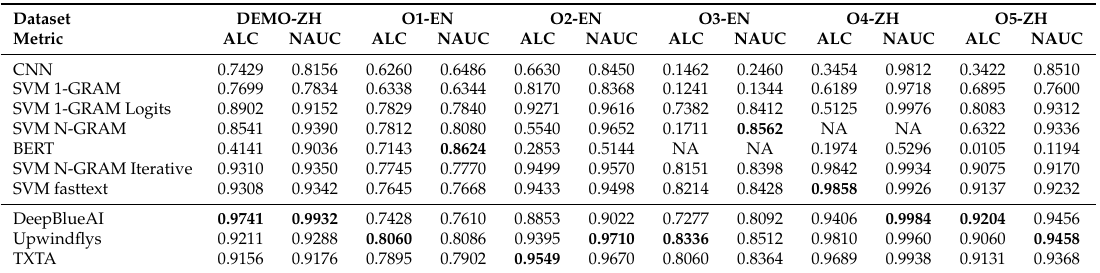
Table 10. Text: ALC and NAUC performance of evaluated text classification models. Best performances are marked in